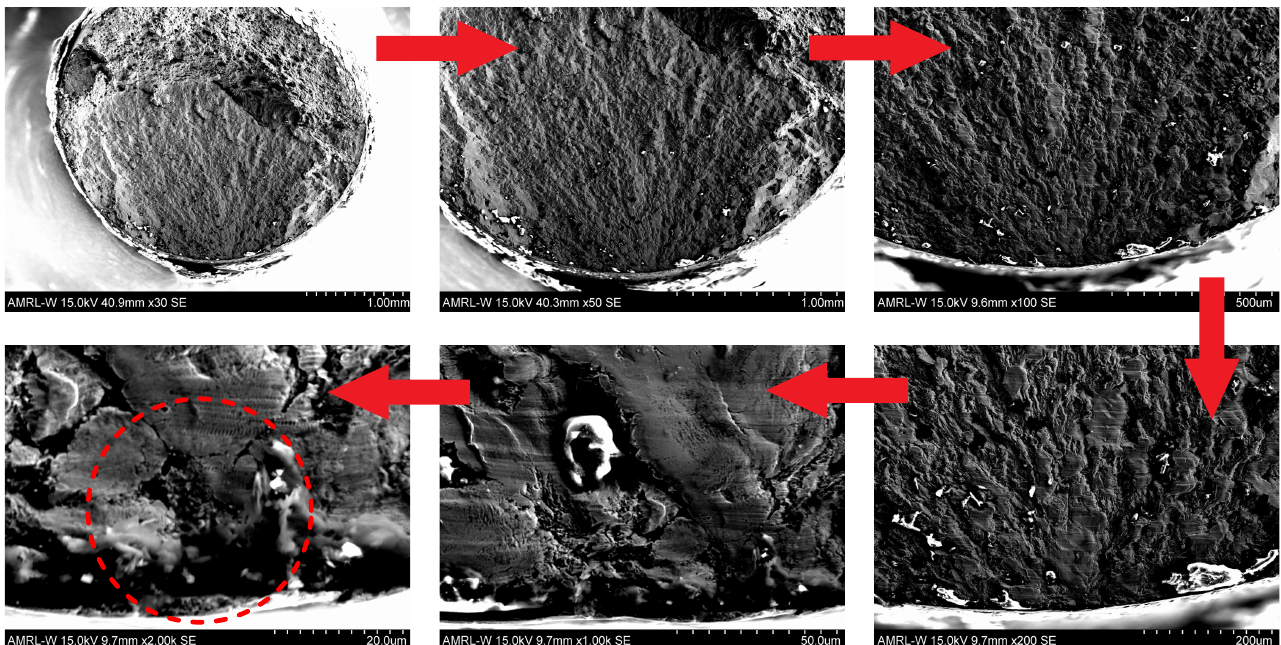
Figure 8. Search for the crack origin on the fracture surface of the sample run at 355 MPa stress amplitude for over 139 million cycles using Hitachi scanning electron